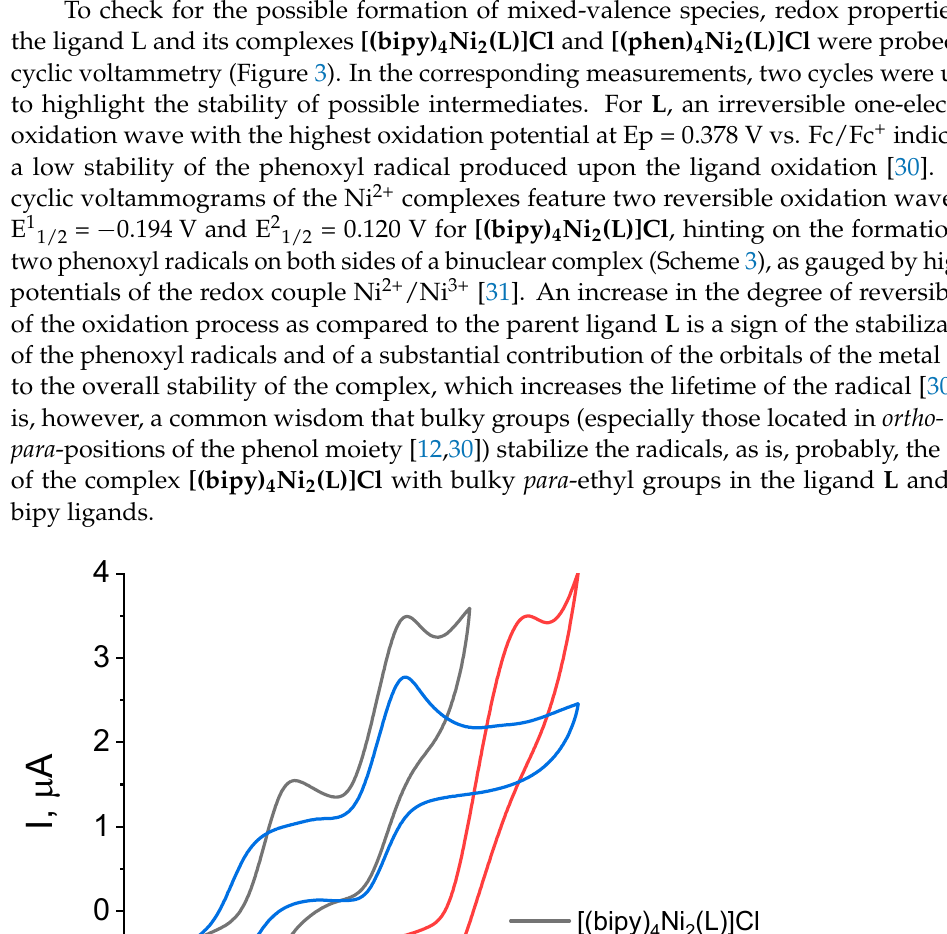
Figure 2. Variable ‐ temperature magnetic susceptibility for a microcrystalline sample ( left ) and a methanol solution ( right ) of [(bipy) 4 Ni 2 (L)]Cl from the dc ‐ magnetometry and the Evans technique, respectively. For the magnetic susceptibility of a methanol solution of [(phen) 4 Ni 2 (L)]Cl , see Figure S7.